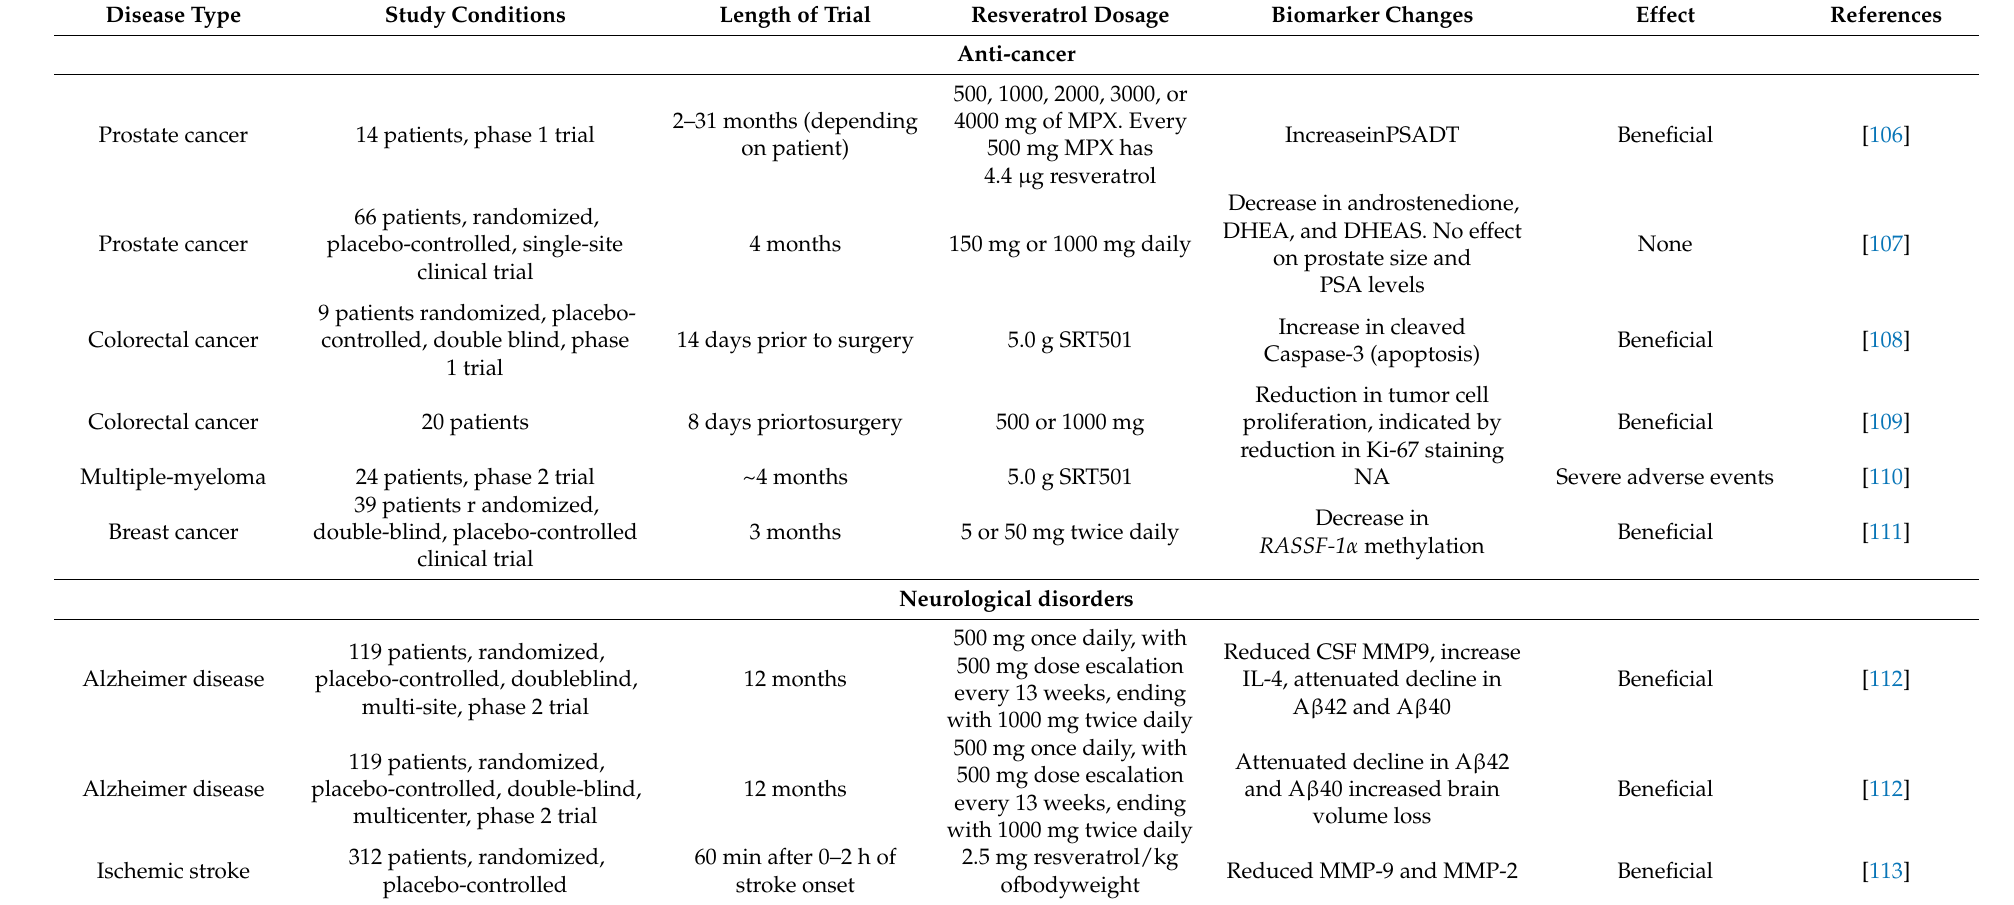
Table 4. Summary of Resveratrol’s clinical